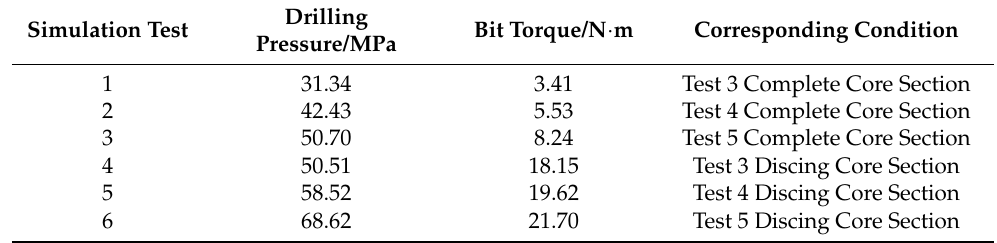
Table 4. Boundary parameters of the numerical model.